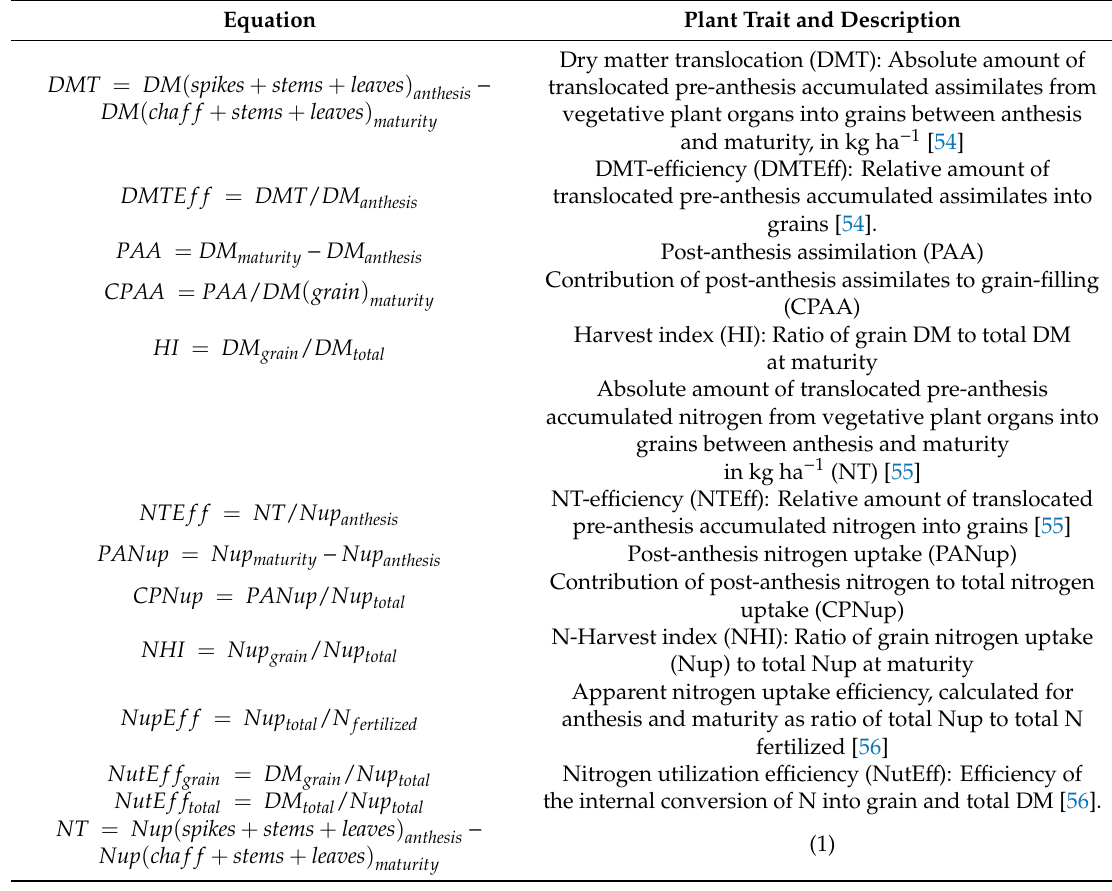
Table 3. List of derived plant traits, which were calculated from ‘direct’ dry matter (DM) and N-uptake (Nup) traits. Dry matter translocation, N translocation, dry matter translocation e ffi ciency, N translocation e ffi ciency, harvest index, and N harvest index were calculated on the total aboveground plant level and on the